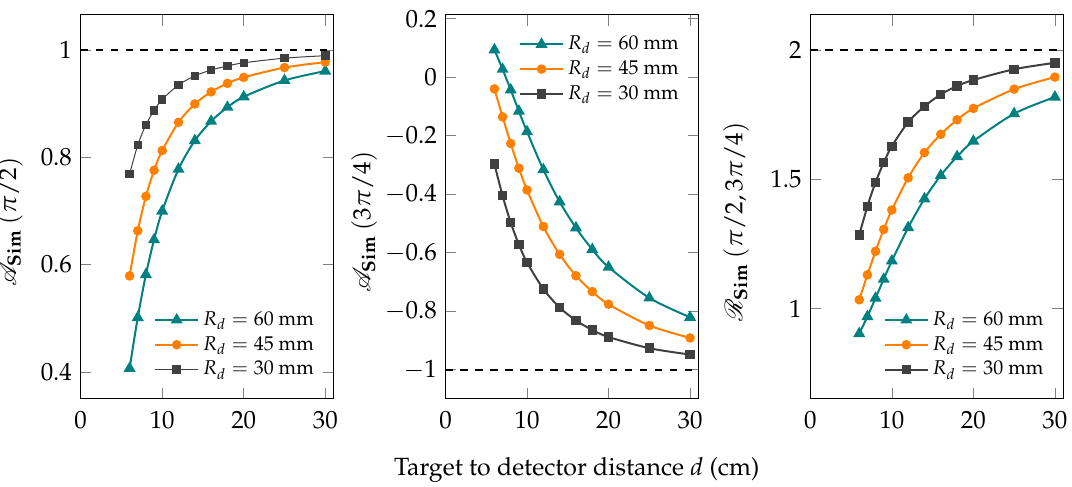
Figure 7. The same as Figure 4 for the quadrupole transition with a spin sequence of 0 → 2 → 0.